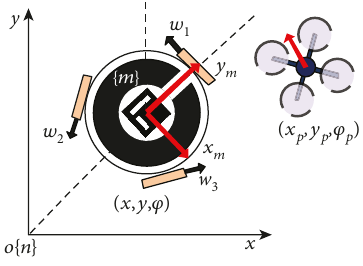
Figure 3: Description of the moving platform coordinate